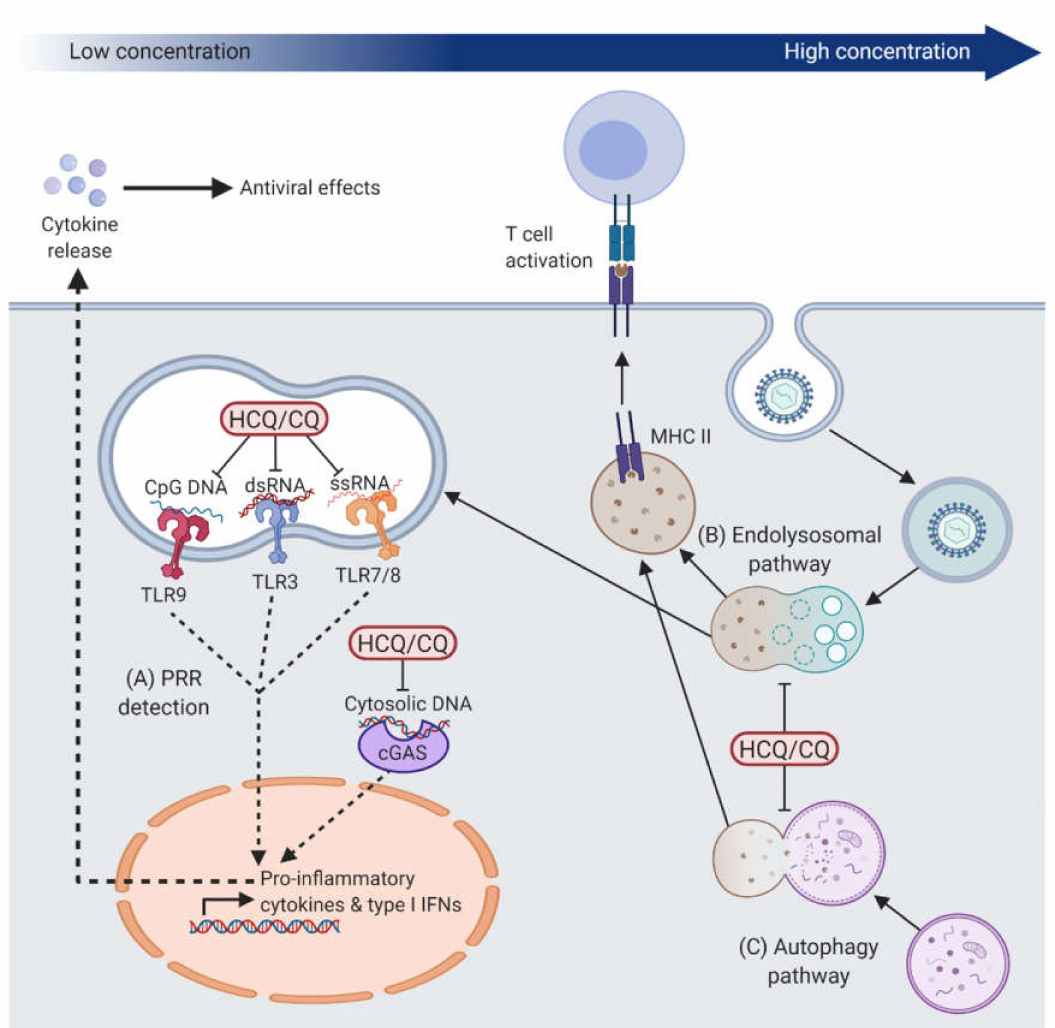
Figure 1. Immunomodulatory mechanisms of hydroxychloroquine (HCQ) and chloroquine (CQ). ( A ) At lower concentrations, which we define as ≤ 20 µ M, HCQ and CQ can inhibit the activation of nucleic acid sensors, Toll-like receptors (TLR) in endosomes and cyclic GMP-AMP synthase (cGAS) in the cytoplasm. This leads to the inhibition of pattern recognition receptor (PRR)-induced activation of downstream pro-inflammatory cytokine and type I interferon (IFN) gene expression. At high concentrations ( ≥ 100 µ M), HCQ and CQ can increase lysosomal pH, which leads to disruption of presentation of ( B ) extracellular antigens processed through the endolysosomal pathway and ( C ) intracellular antigens processed through the autophagosome-lysosome fusion pathway by antigen presenting cells. dsRNA, double-stranded RNA; ssRNA; single-stranded RNA; MHC II, major histocompatibility complex class